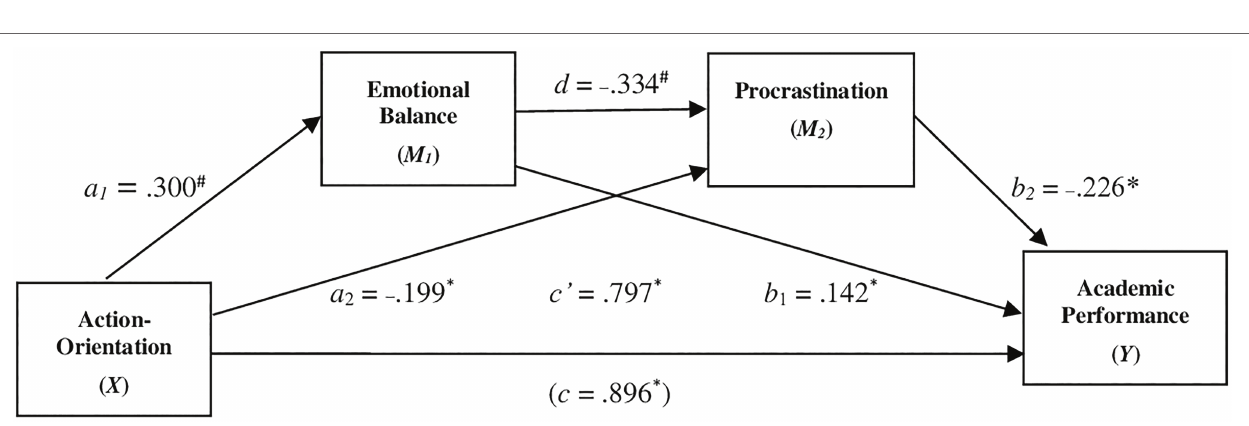
FIGURE 1 | The mediating effect of emotional balance in the relationship between Self-Regulation and procrastination. # p < 0.001, * p < 0.05; all presented effects are unstandardized; a is effect of Self-Regulation on Emotional Balance; b is effect of Emotional Balance on Procrastination; C ʹ is direct effect of Self-Regulation on Procrastination. C is total effect of Self-Regulation on Procrastination.